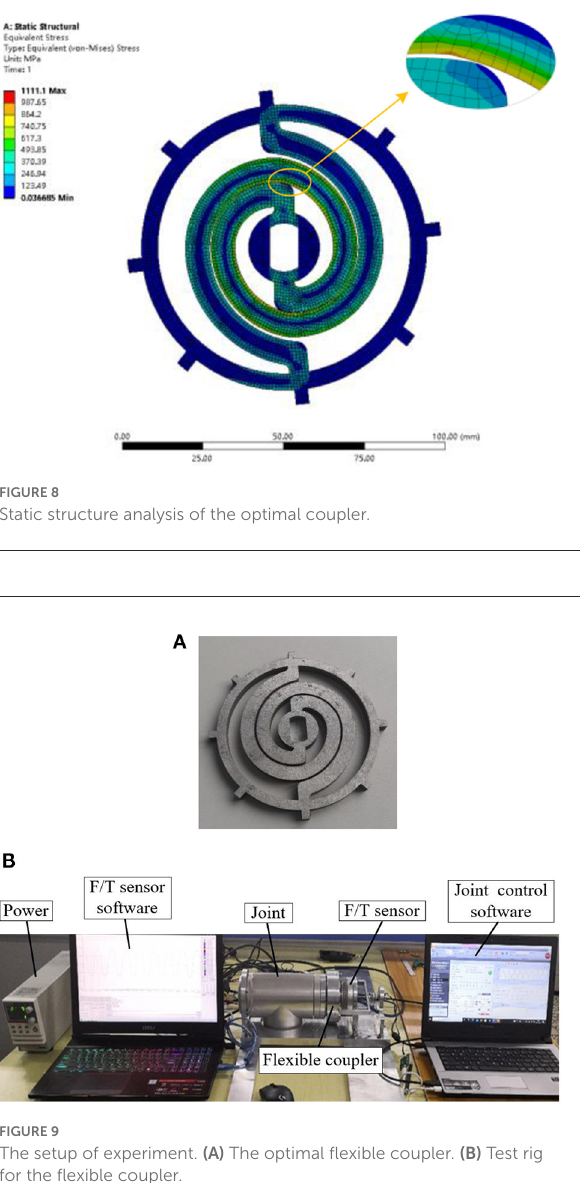
TABLE 8 The information of F/T sensor.